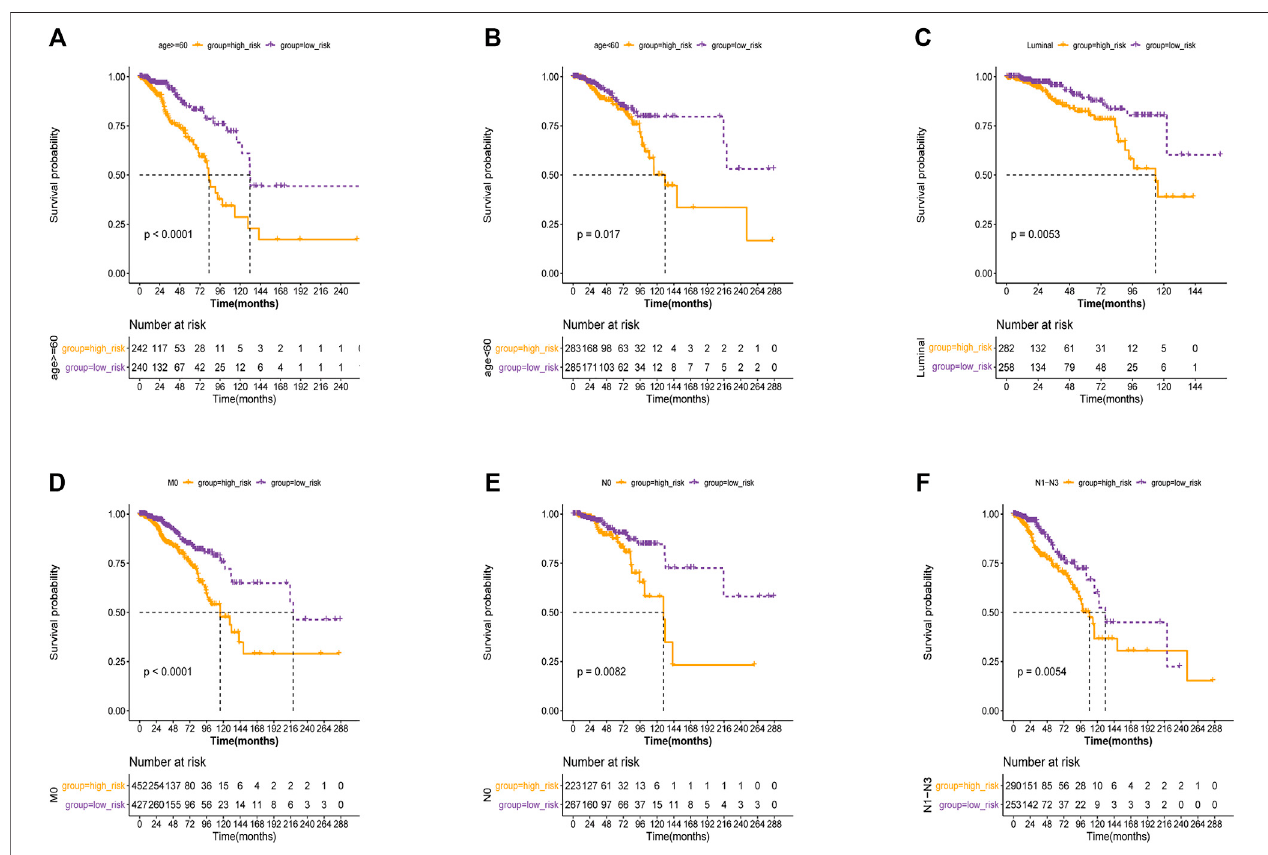
FIGURE 3 | Kaplan – Meier survival stratifcation analyses in TCGA database based on stemness-index-related lncRNA signature. Age > = 60 years (A) , age < 60 years (B) , female (C) , M0 (D) , N0 (E) , N1 – N3 (F) , stages i – ii (G) , stages iii-iv (H) , T1 – T2 (I) , T3 – T4 (J) .